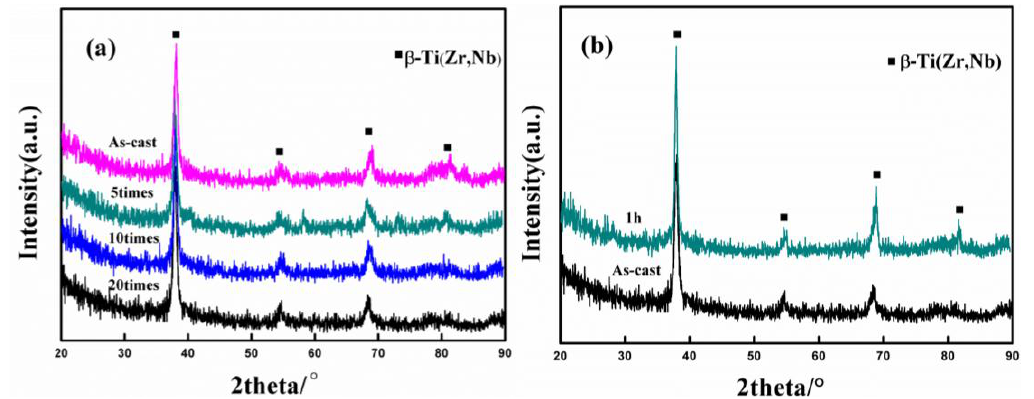
Figure 3. XRD patterns ( a ) after annealing for 1 min per cycle and ( b ) one cycle for different times in LN.